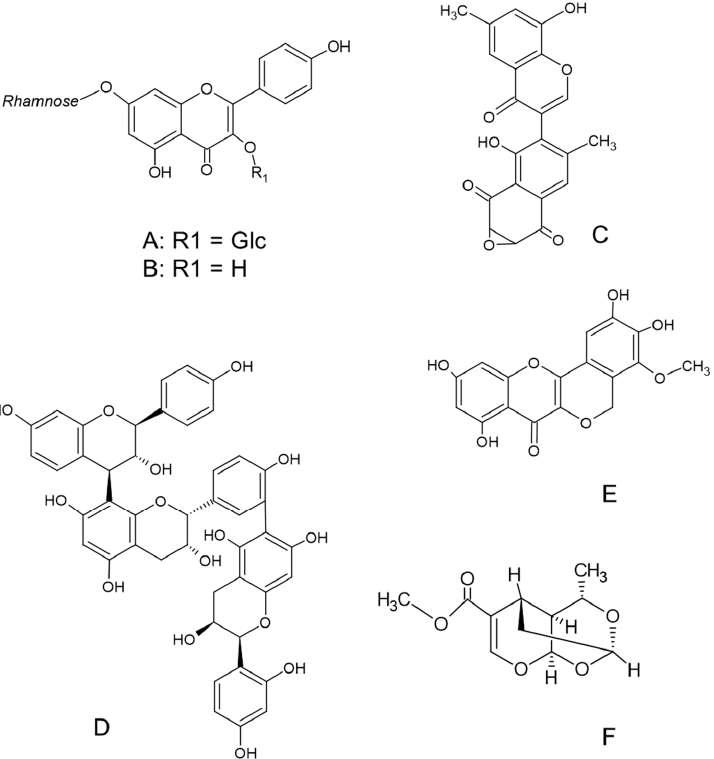
Figure 1. Structures of the most important compounds: kaempferol 3- O - α -D-glucopyranoside-7- O - α - L -rhamnopyranoside ( A ) [42], α -rhamnoisorobin ( B ) [42], diosquinone ( C ) [46], cassinidin A ( D ) [47], etandanin ( E ) [48], and sarracenin ( F ) [49].